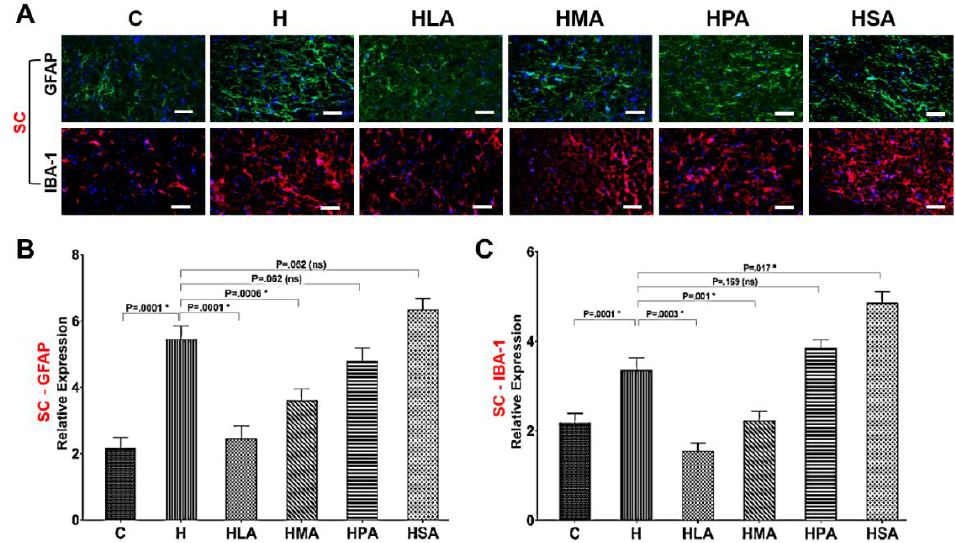
Figure 5. Glial cell activation in the spinal cord (SC). (A) Typical dorsal sections of the SC showing astrocyte (GFAP – astrocyte marker) and microglia (IBA-1 – microglia marker) activation in OA rats fed the different diets. Quantification of GFAP (B) and IBA-1 (C) mRNA levels in the SC was performed using qPCR. All values are represented as mean ± SD, n = 4. C, corn starch diet-fed rats; H, high-carbohydrate high-fat diet-fed rats; HLA, high-carbohydrate high-lauric acid diet-fed rats; HMA, high-carbohydrate high-myristic acid diet-fed rats; HPA, high-carbohydrate high-palmitic acid diet-fed rats; HSA, high-carbohydrate high-stearic acid diet-fed rats.